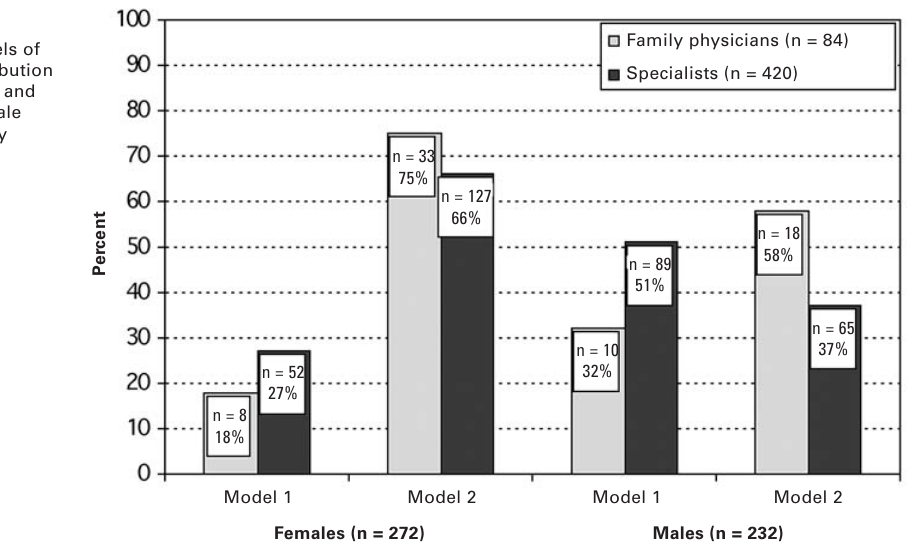
Figure 2 Favoured models of workload distribution between father and mother by female and male family physicians and